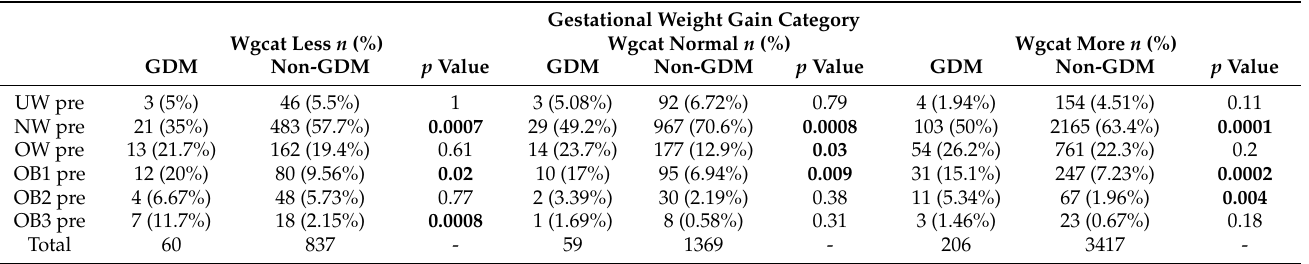
Table 2. Gestational weight gain category for the different BMI subgroups classification for the overall population (GDM, non-GDM). Gestational Weight Gain Category Wgcat Less n (%) Wgcat Normal n (%)